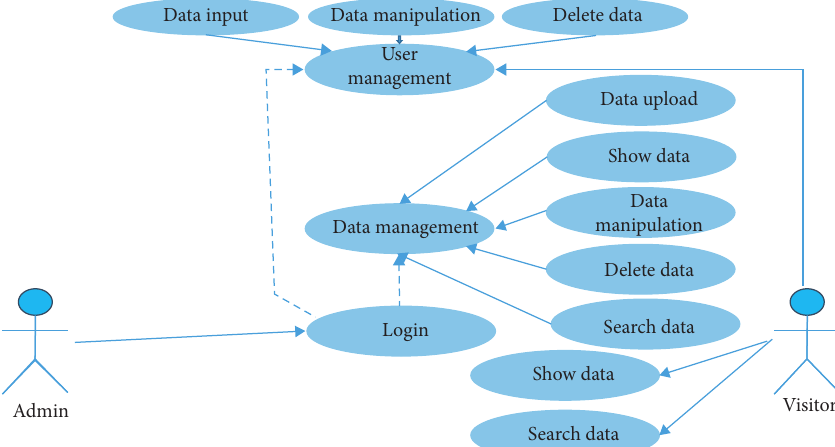
Figure 1: Use-case diagram.